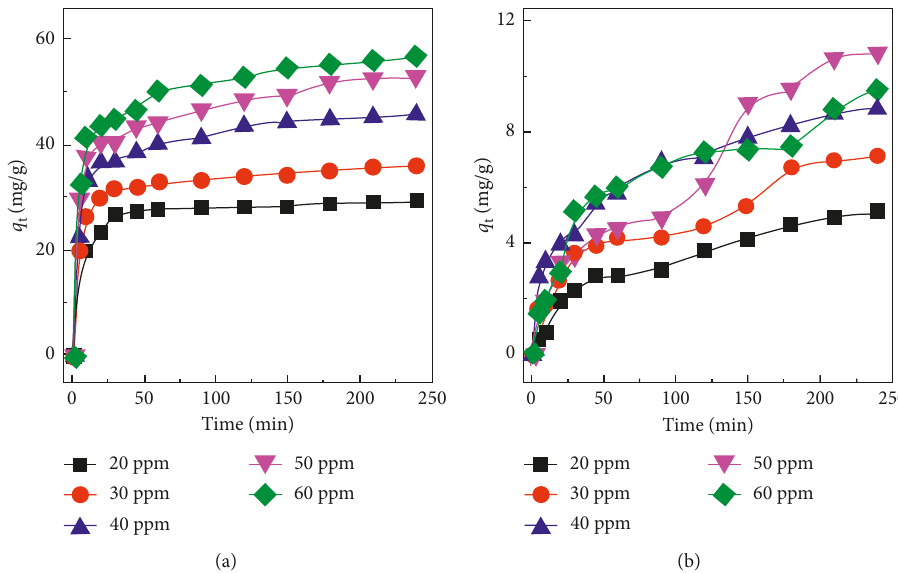
Figure 8: Effect of material dosage on CR adsorption capacity onto EG@MnFe 2 O 4 (a) and MnFe 2 O 4 (b). Experimental conditions: solution volume of 100mL, and dye concentrations of 20–60 mg/L at pH 4 for MnFe 2 O 4 and pH 6 for EG@MnFe 2 O 4 . Experiments were run at room temperature (25 ° C) during the period of